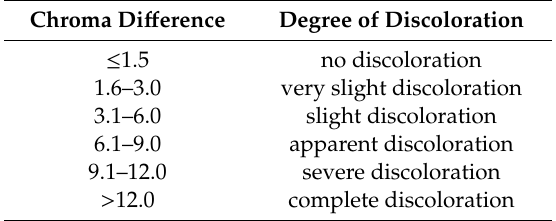
Table 4. Relationship between the Chroma Di ff erence and the Degree of